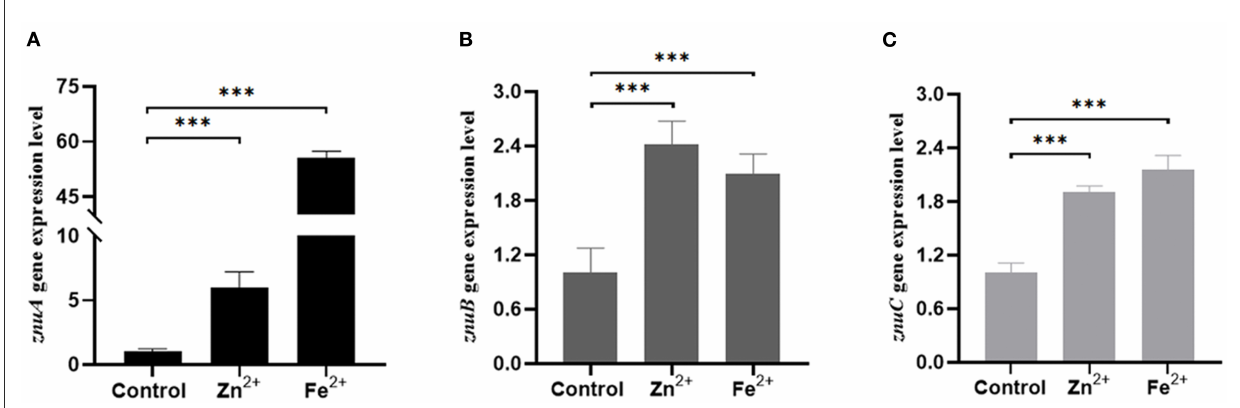
FIGURE3 Determination of the expression levels of znuA , znuB, and znuC in Zn 2 + and Fe 2 + limitation. (A) was the expression level of znuA in Zn 2 + and Fe 2 + restriction. (B) was the expression level of znuB in Zn 2 + and Fe 2 + restriction. (C) was the expression level of znuC in Zn 2 + and Fe 2 + restriction. Data were presented as mean ± standard deviation (SD) ( n = 3). *** P < 0.001.